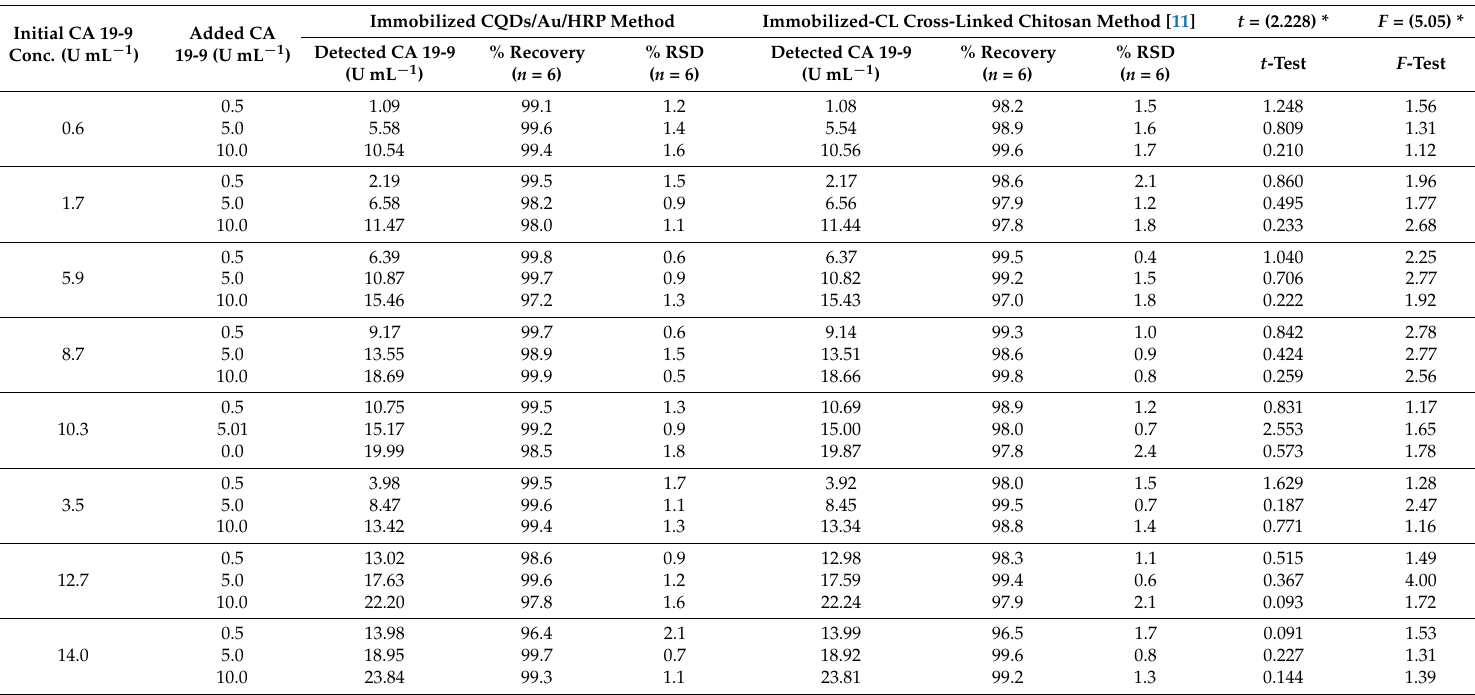
Table 4. Comparative quantitative determination of CA 19-9 antigen in real serum samples using fluorescence-based CQDs/Au–Ab–HRP immunoassay method and immobilized-Chemiluminescence cross-linked chitosan method